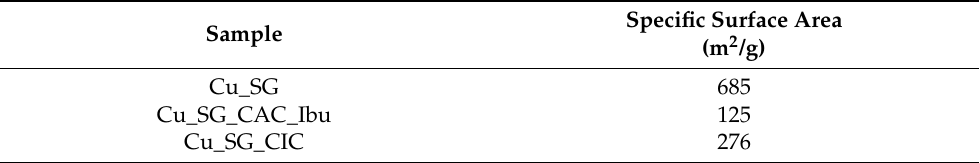
Table 1. The specific surface area of Cu_SG, Cu_SG_CAC_Ibu and Cu_SG_CIC.